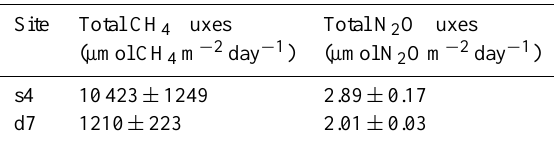
Table 1. Total water–air methane and nitrous oxide fluxes at the shallow site s4 and the deep site d7 of the detailed study. Fluxes are given as the average determined over the 5 consecutive days ± SE, n = 30.